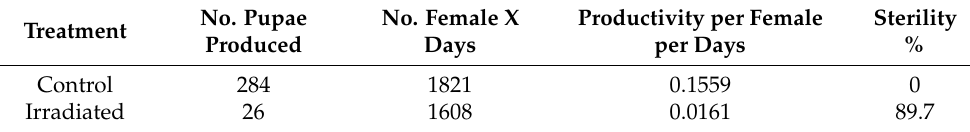
Table 3. Effect of irradiation on the fertility of irradiated male tsetse flies. No. Pupae No. Female X Productivity per Female Sterility Treatment Produced Days per Days % Control 284 1821 0.1559 0 Irradiated 26 1608 0.0161 89.7